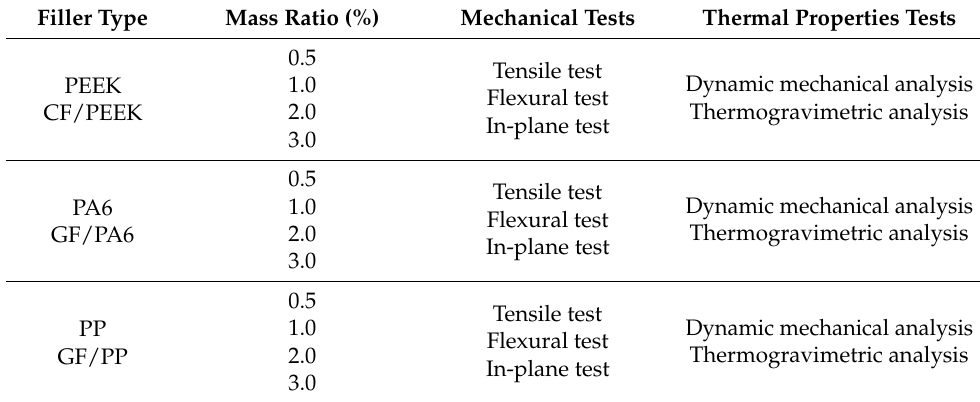
Table 1. Test conditions of adding thermoplastic resin and its composite to Ts